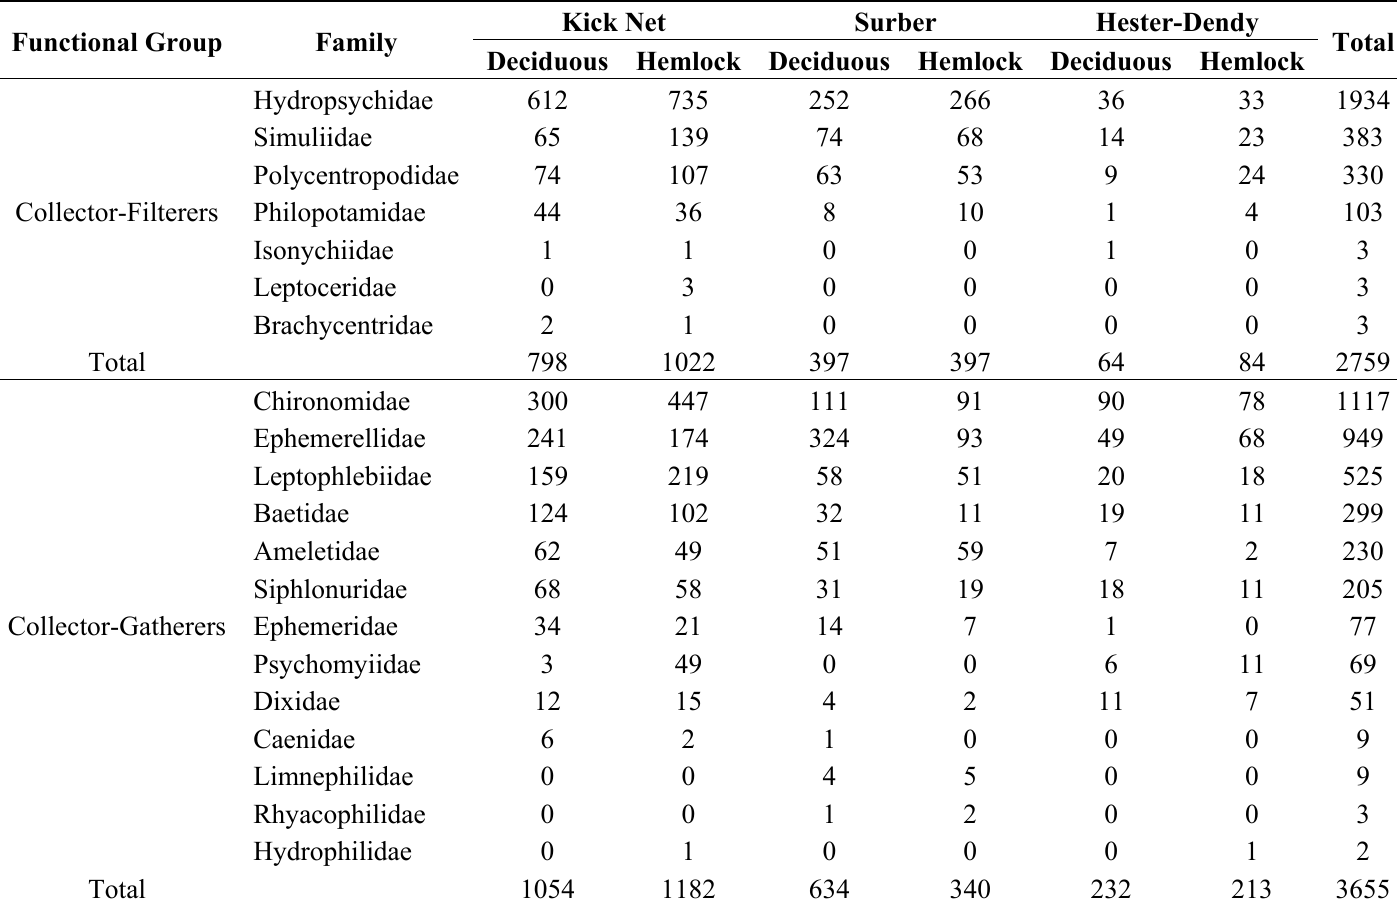
Table 1. Number of individuals from predominant collector-filterer, collector-grazer, and grazer families collected from kick net, Surber, and Hester-Dendy samples from eastern hemlock and deciduous dominated headwater streams,